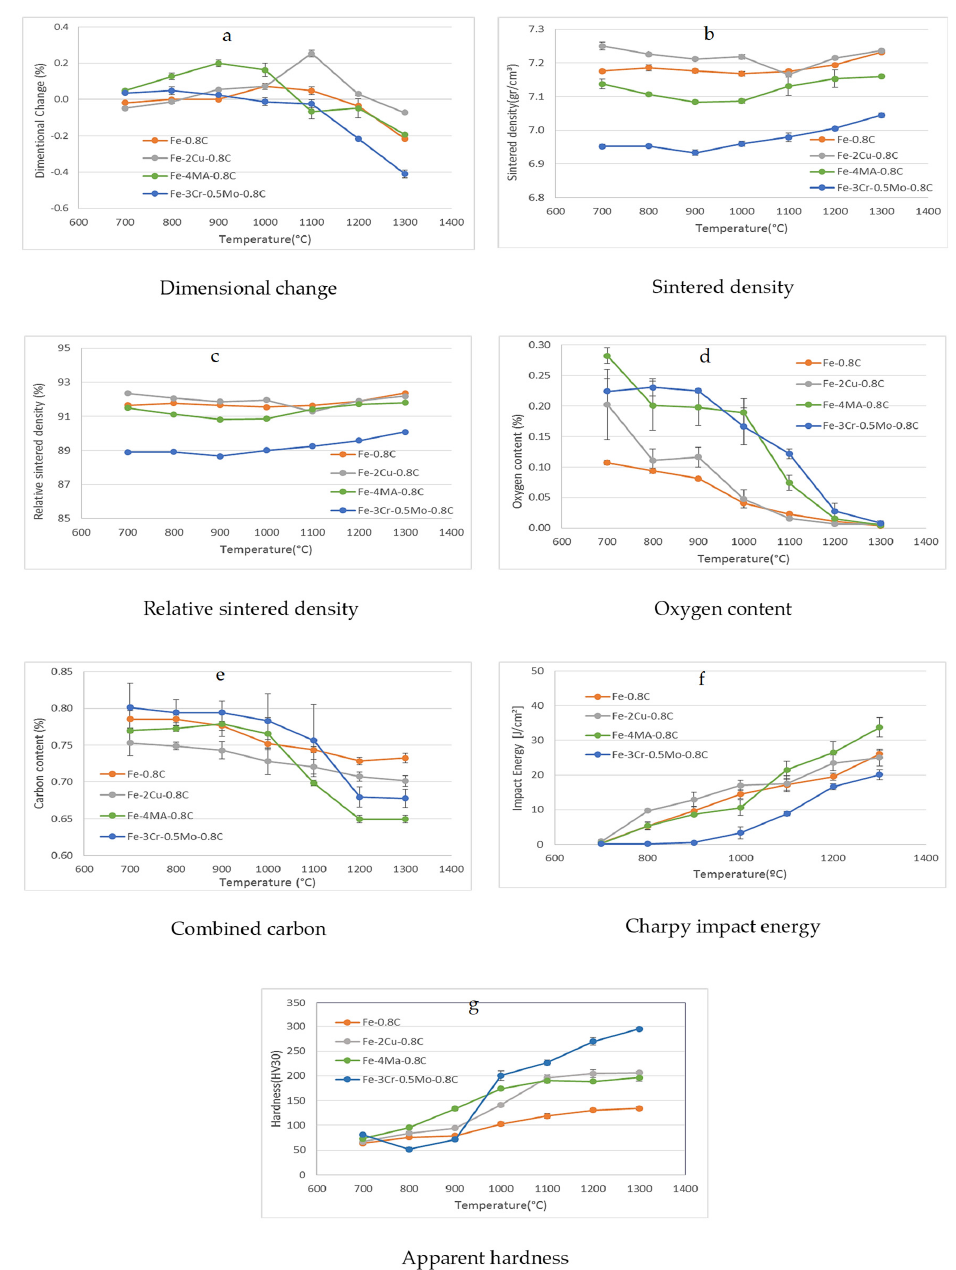
Figure 8. Sintered properties of steels compacted at 600 MPa and sintered for 60 min at different temperatures in Ar.